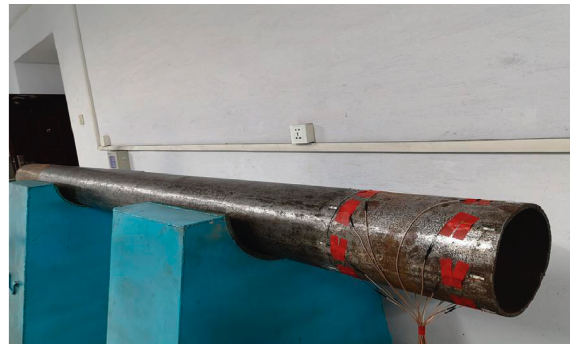
Figure 29: Piezoelectric ceramic sensor paste.